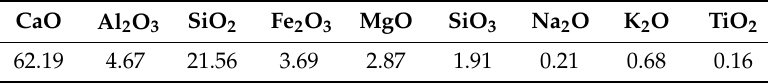
Table 3. Main minerals of the rock core (RC) specimens (wt. %). Table 2. Chemical composition of Portland cement PC 32.5R (wt. %)